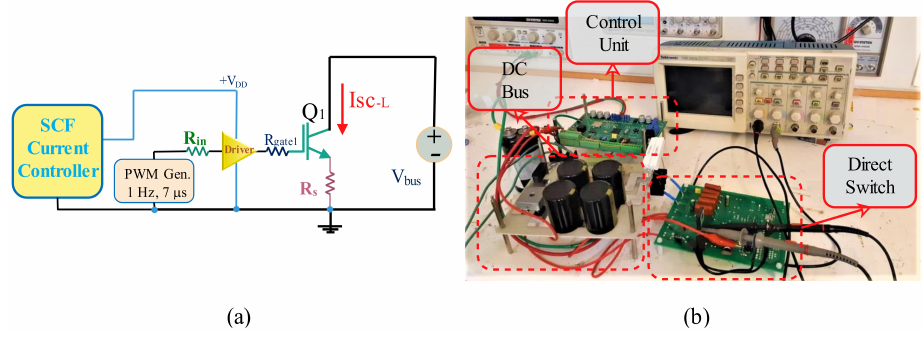
Figure 16. ( a ) The block diagram and ( b ) the photo of the experimental